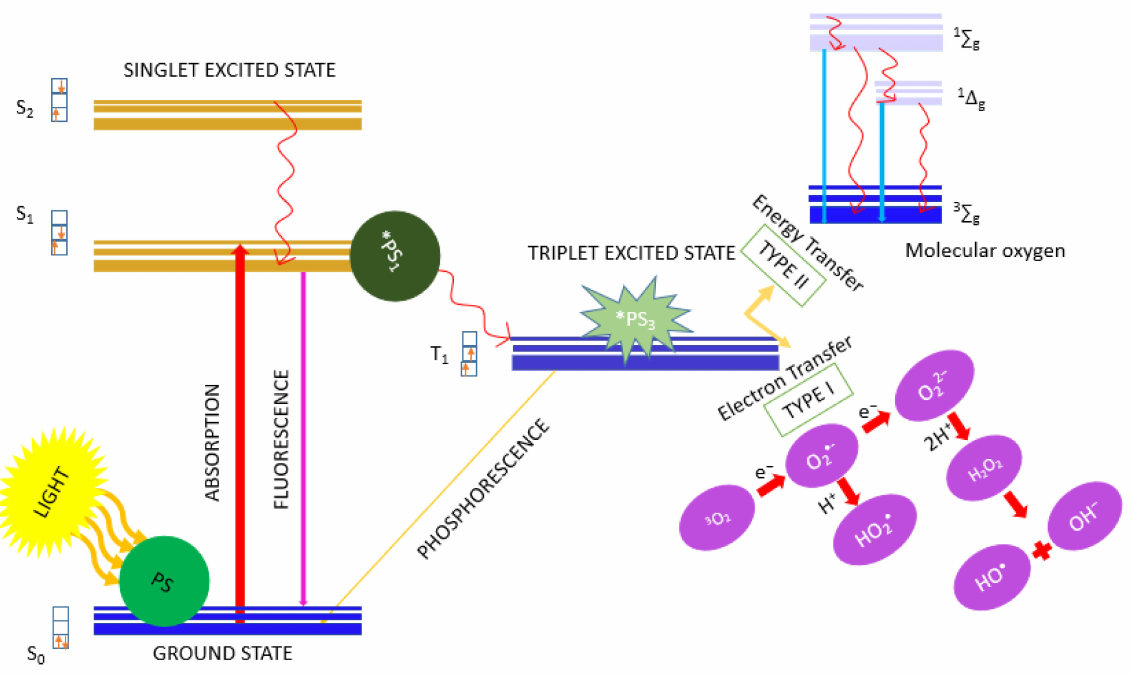
Figure 1. Type I and Type II pathways that elicit photodynamic action. The Jabło´nski diagram above is a simplified graphical representation of Type I and Type II pathways that occur when a PS absorbs visible light. Singlet states are represented by S, and triplet states by T. The wavy arrows indicate internal conversion and intersystem crossing. Straight arrows illustrate transitions in which radiation is emitted or absorbed. S 0 —singlet ground state, S 1 —first singlet excited state, S 2 —second singlet excited state, PS—ground-state photosensitizer, *PS 1 —singlet excited-state photosensitizer, *PS 3 —triplet excited-state photosensitizer, 1 ∆ g —singlet oxygen (excited state), 1 ∑ g —upper state excited, 3 ∑ g —triplet oxygen (ground